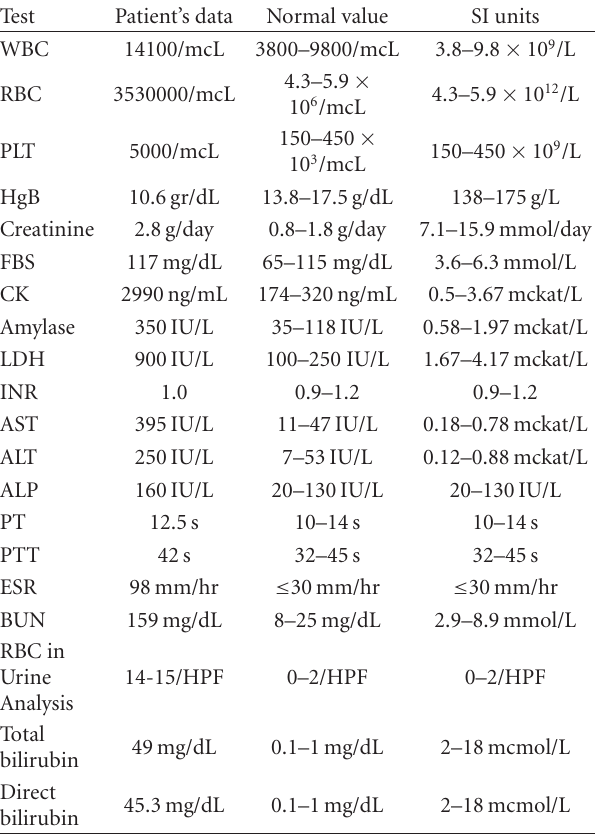
Table 1: Laboratory